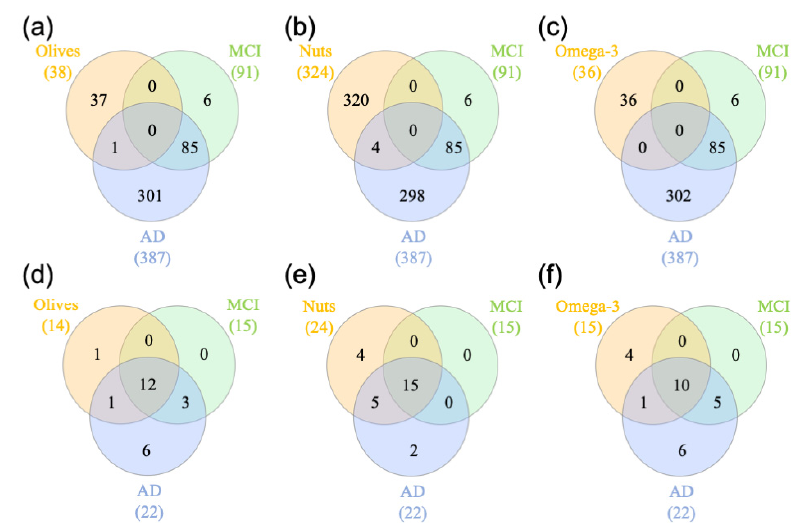
Figure 7. Comparison of gene expression data from supplemented diets to mild cognitive impairment (MCI) and Alzheimer’s disease (AD). ( a – c ) The shared genes between a specific supplemented diet, MCI, and AD were analyzed by Venn ( a ): olive-supplemented diet, ( b ): nuts-supplemented diet, ( c ): omega-3-supplemented diet. ( d – f ) The shared transcription factors between a specific diet, MCI, and AD were analyzed by Venn ( d ): Olive-supplemented diet, ( e ): Nuts-supplemented diet, ( f ): omega-3-supplemented diet.